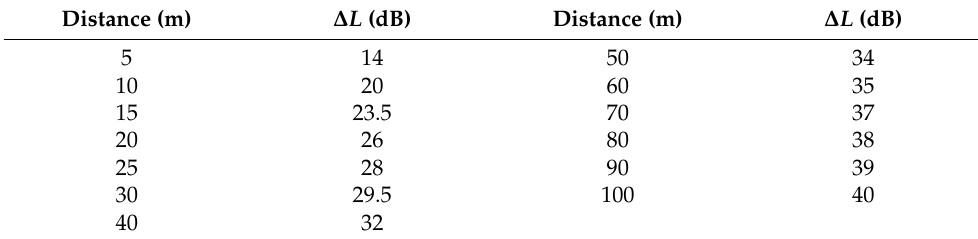
Table 1. Point source distance attenuation values.